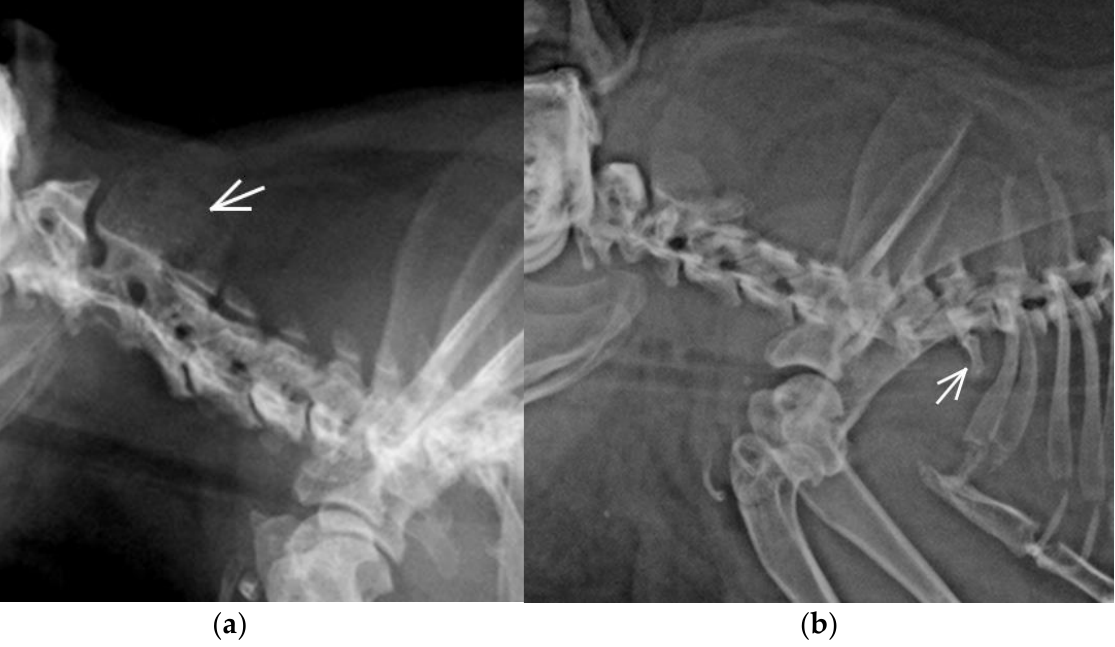
Figure 2. Lateral radiographs of the cervical (C) vertebral column in two guinea pigs: ( a ) Block vertebra C2-C3 with a fusion of vertebral body, one common spinal process (arrow) and eight C vertebrae; ( b ) Cervicothoracic transitional vertebra (CTV) identified in this guinea pig was morphologically characterised by a unilateral ventral oriented rudimentary rib (arrow).